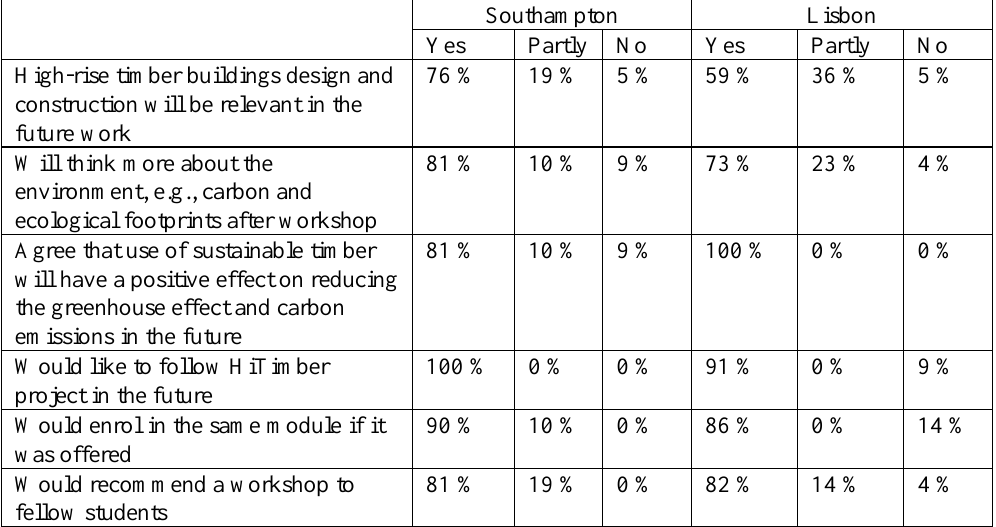
Table 1. Impact of Workshops as Evaluated by Students (developed by the authors, based on survey